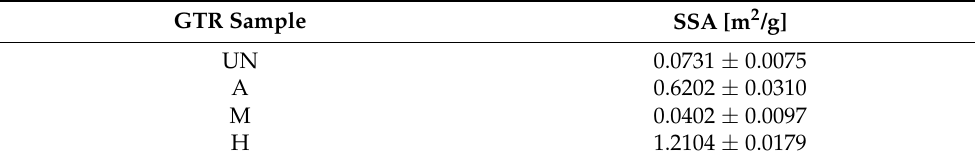
Figure 3. Optical microscope picture of untreated (virgin—GTR UN), sulfuric acid activated (GTR A), subjected to modification (GTR M) or hybrid treatment (GTR H) GTR particles. The specific surface area of the ground tire rubber particles treated with sulfuric acid (GTR A) increased ca. 10 times in comparison to the virgin GTR (Table 2), the same as presented by Colom et al. [32]—to 0.6202 ± 0.0224 m 2 /g. Table 2. Specific surface area (SSA) of the GTRs studied as determined by